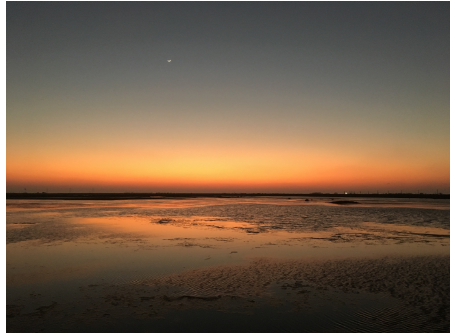
Figure 3. An example of horizontal